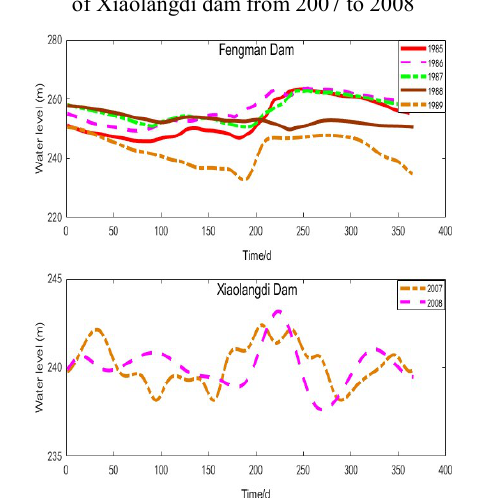
Figure.3 Observed horizontal displacement of the dam crest of Xiaolangdi dam from 2007 to 2008